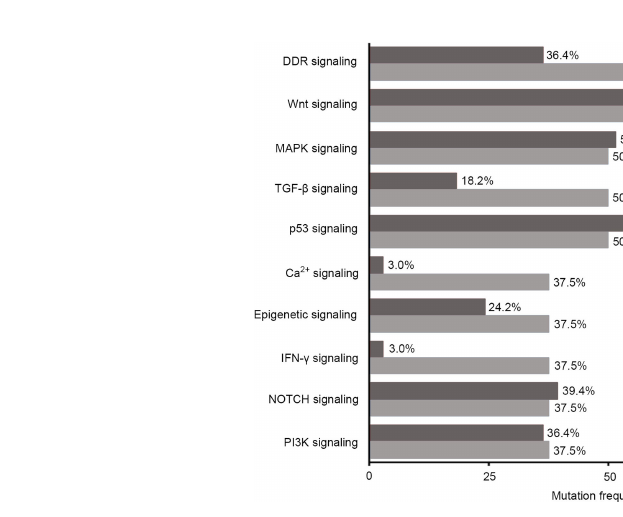
FIGURE 6 | Comparison between SCRC and NSCRC patients of the detection rate of genomic mutations in signaling